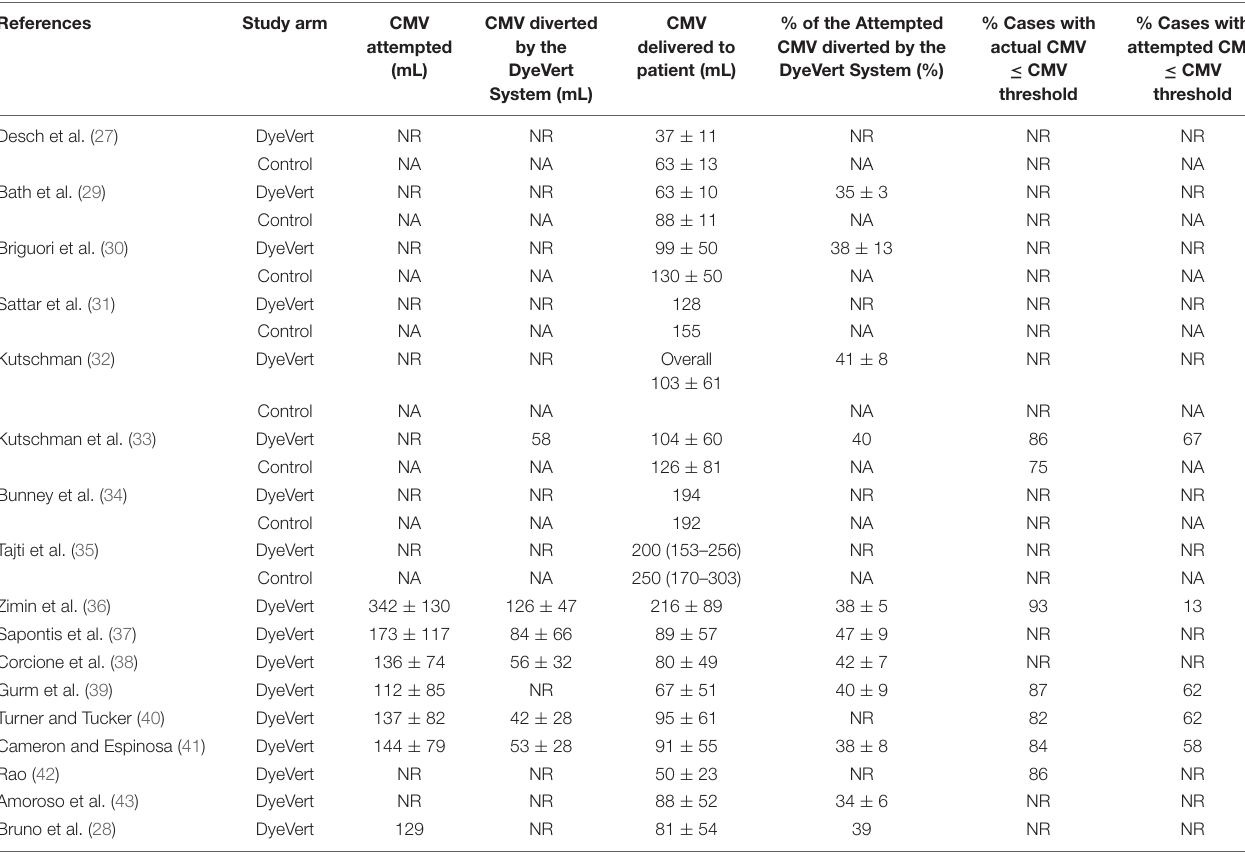
TABLE 4 | Contrast media volume and threshold